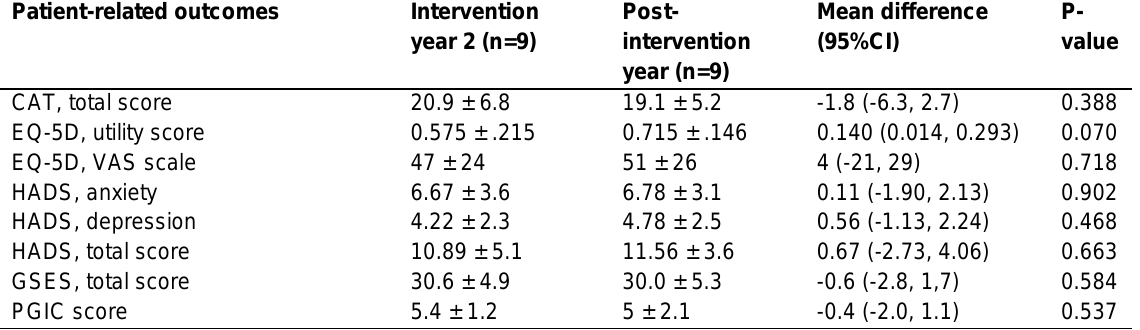
Table 5. Patient-related Outcomes (Second Year of the Telerehabilitation vs. Post-intervention Year) Patient-related